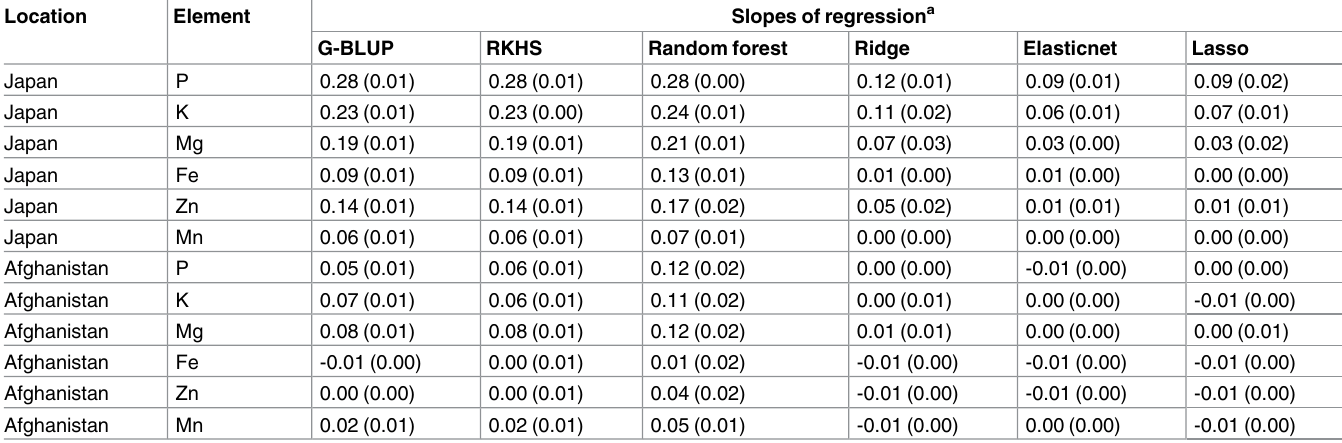
Table 4. Slopes for the genomic prediction plot (regression of predicted values on observed